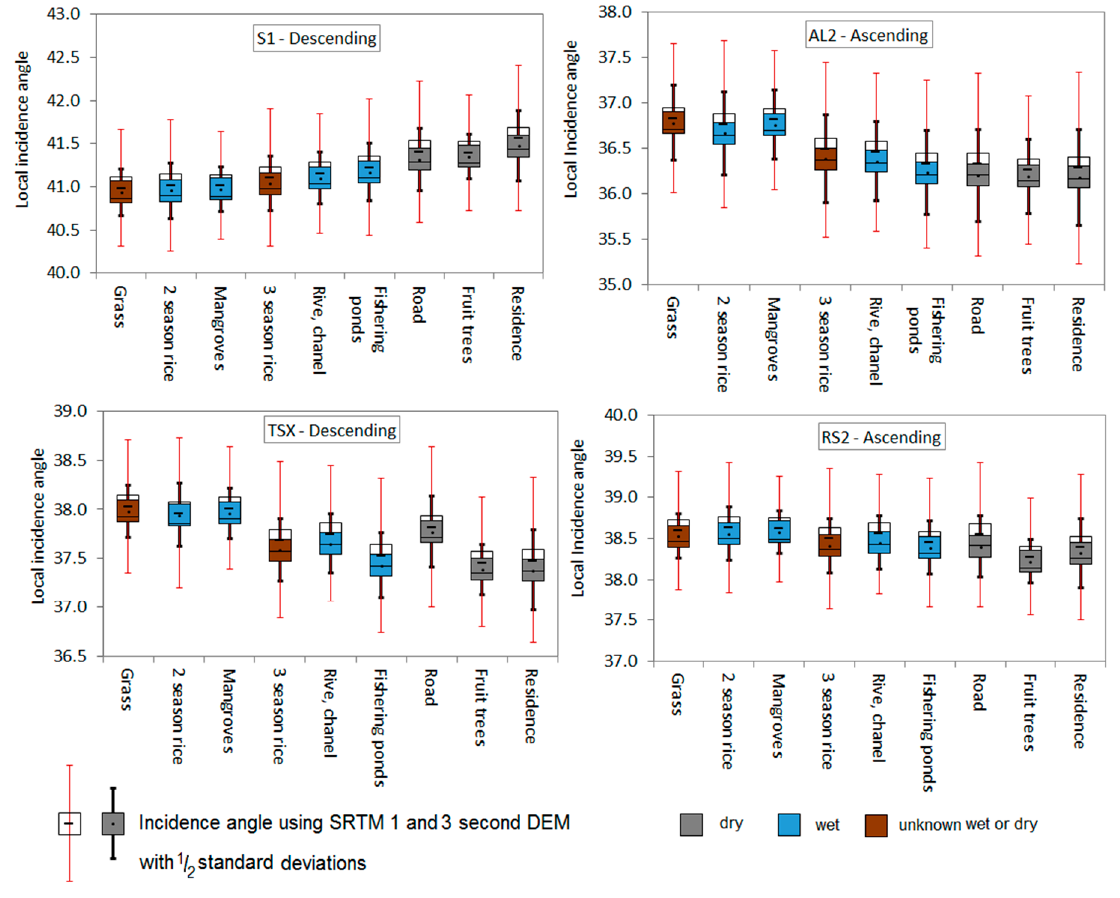
Figure 11. Relationship between local incidence angles and land use types with effects of DEM resolution (1 and 3 s Shuttle Rada Topography Mission (SRTM)).